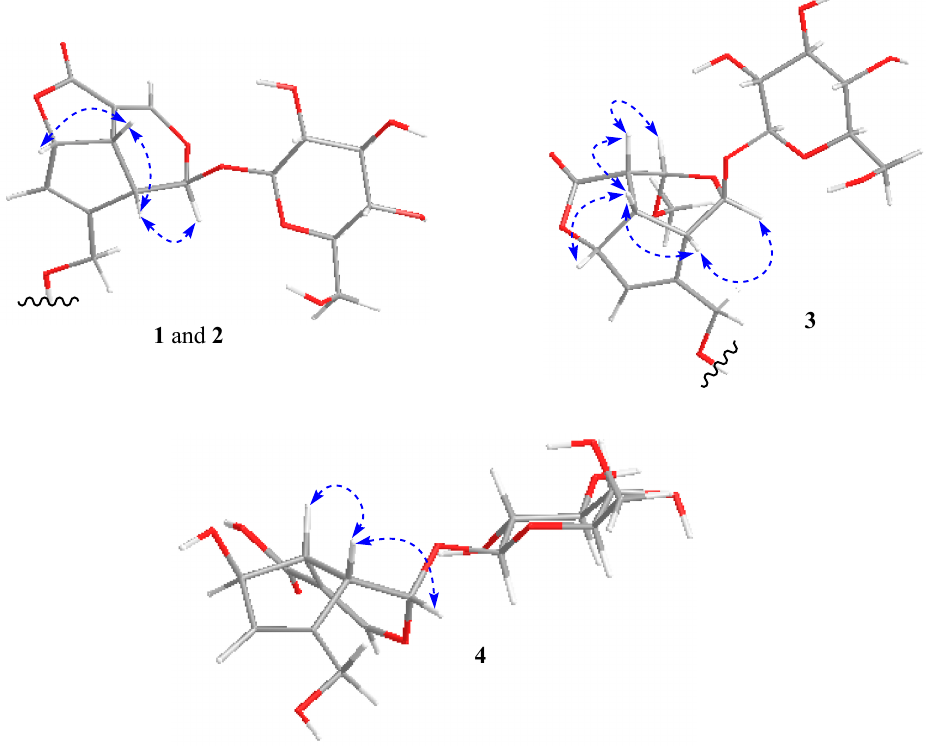
Figure 6. Dotted double-head arrows represent selected NOESY correlations of compounds 1 – 4 .